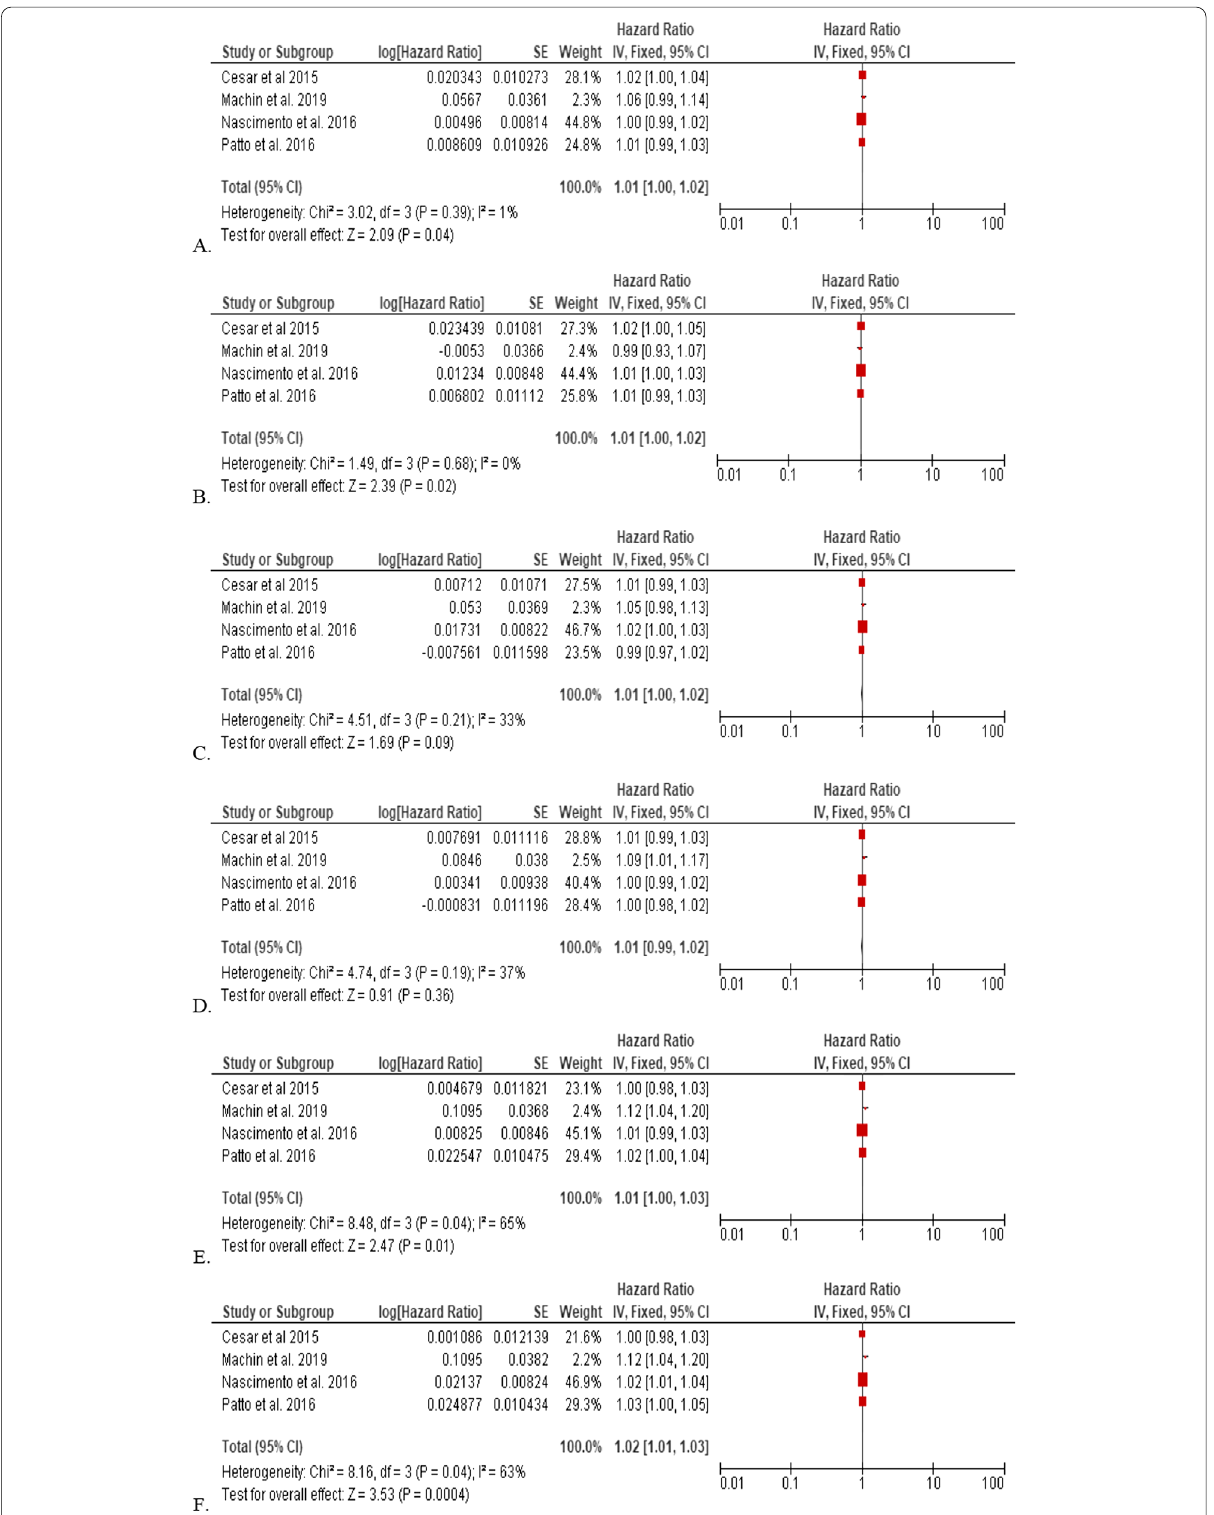
Fig. 2 Forest plots of hazard ratios A Lag0, B Lag1, C Lag2, D Lag3, E Lag4, F